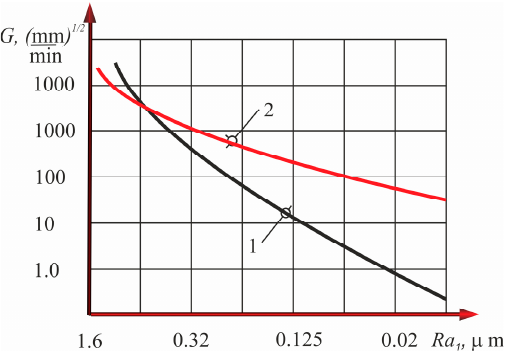
Figure 6. The dependence of the performance indicator on surface roughness after grinding: 𝑉 𝐾 = 35 m · sec −1 ; 1: 𝑙 = 35 m · s − 1 ; 1 : l K